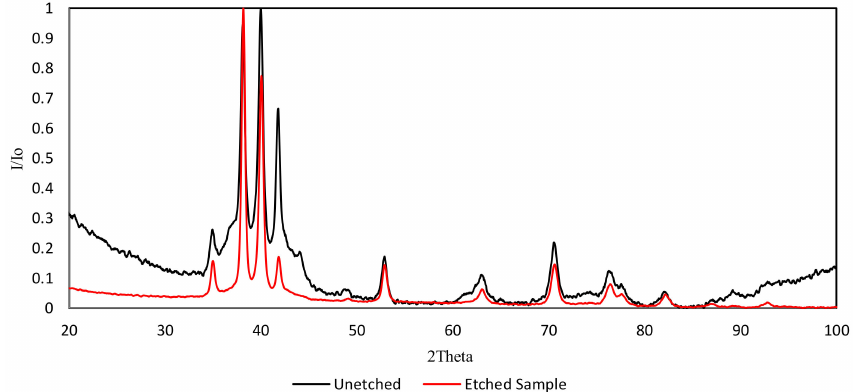
Figure 5. XRD Comparison between etching and without etching.